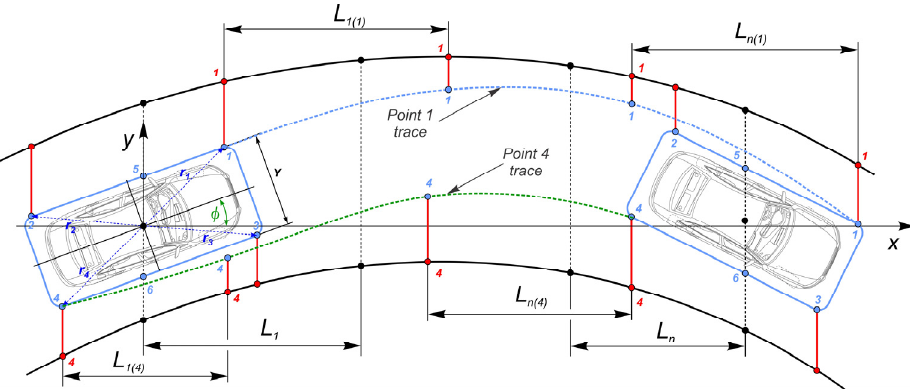
Figure 6. Forming control points’ traces for use in integral equality constraints.